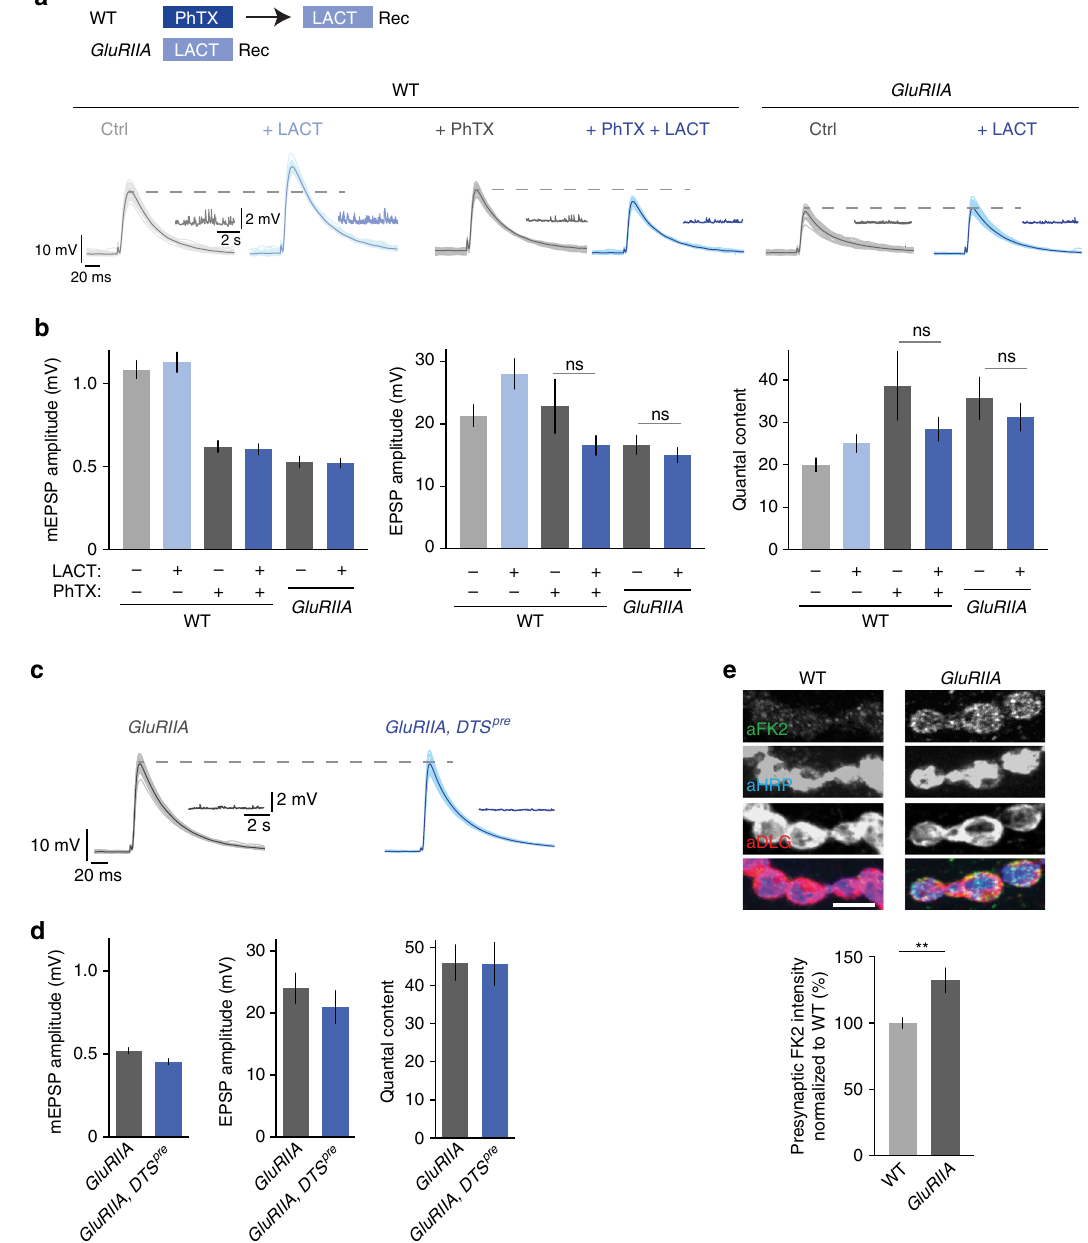
Fig. 2 Proteasome perturbation does not potentiate release after acute induction or sustained expression of PHP. a Scheme for treatment of NMJs and representative EPSP and mEPSP traces. Wild-type NMJs were incubated with saline or 20 µ M PhTX for 10 min, followed by a wash and treatment with saline or 100 µ M lactacystin for 30 min at 0.3 mM [Ca 2+ ] e . GluRIIA -mutant synapses were treated with saline or 100 µ M lactacystin for 30 min at 0.3 mM [Ca 2+ ] e . b Quanti fi cation of EPSP amplitude, mEPSP amplitude and quantal content for larvae treated as described in ( a ). Lactacystin application to larvae treated with PhTX or to GluRIIA -mutant larvae has no effect on EPSP amplitude or quantal content. Mean ± s.e.m.; n ≥ 10 cells; ns: not signi fi cant; Student ’ s t -test. c Representative EPSP and mEPSP traces of GluRIIA- mutant synapses and GluRIIA,DTS pre double-mutant synapses. d Quanti fi cation of mEPSP amplitude, EPSP amplitude and quantal content of the genotypes described in ( c ). Presynaptic proteasome perturbation does not increase EPSP amplitude or quantal content in GluRIIA -mutant synapses. Mean ± s.e.m.; n ≥ 7 cells. e ) Representative NMJs stained for mono- and polyubiquitinated proteins (aFK2), neuronal membrane (aHRP, horseradish peroxidase), and postsynaptic reticulum (aDLG, discs large) of wild-type and GluRIIA- mutant larvae (scale bar, 5 µ m). Quanti fi cation of FK2- fl uorescence intensity in the HRP mask (presynapse) suggests that GluRIIA -mutant NMJs have higher levels of mono- and polyubiquitinated proteins compared to wild-type NMJs. Mean ± s.e.m.; n = 24 NMJs; ** p < 0.001; Student ’ s t